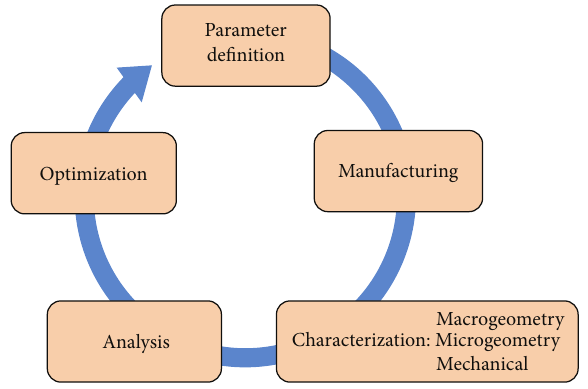
Figure 2: Central iterative